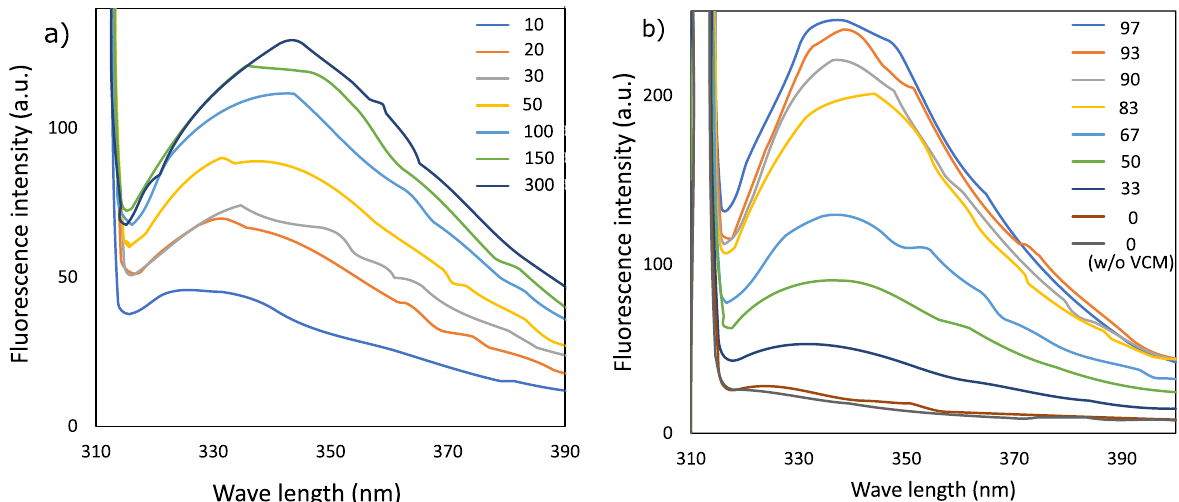
Fig. 3 a The relationship between elution volume and quantity of VCM, b relationship between ratio of DMSO to 10% methanol solution and quantity of VCM. Fluorescence spectra were obtained when excited at 290 nm. The sample volume was adjusted to 300 μL by adding 10% methanol solution before the fluorescence